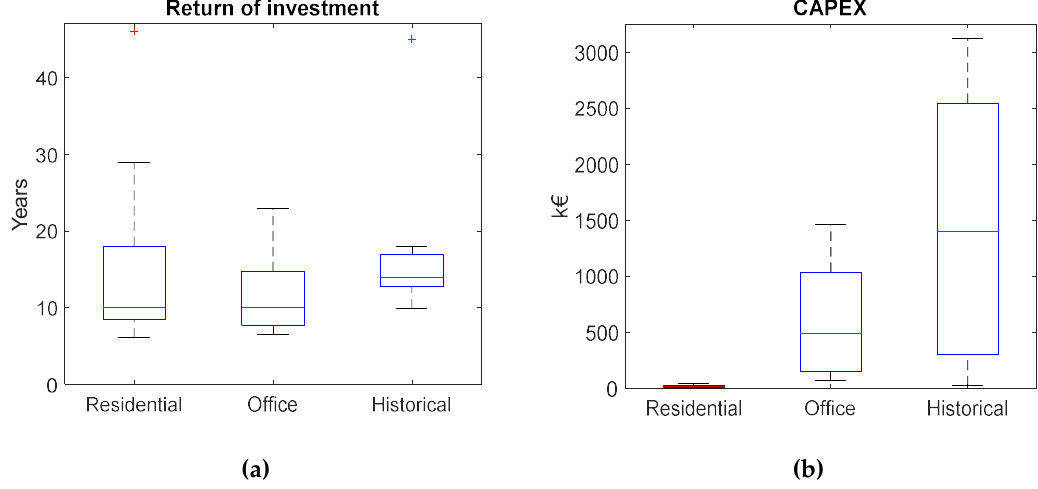
Figure 6. Return of investment ( a ) and capital expenditure ( b ) for three types of buildings.